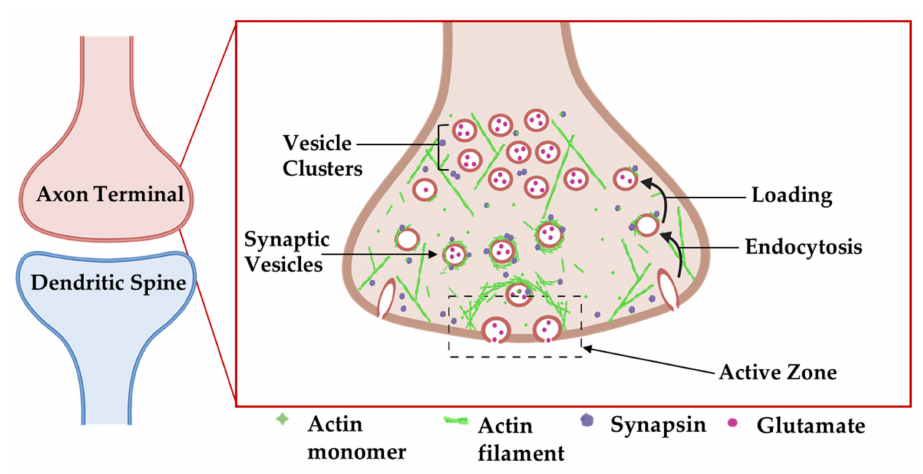
Figure 4. Organization of actin cytoskeleton at the presynaptic axon terminal. Actin filaments form structures presynaptically that affect synapse structure and function. Actin-associated proteins localize to specific areas to carry out their functions. Adapted from “Axonal-dendritic synaptic cleft and Protruding membrane”, by https://BioRender.com (accessed on 26 January 2022) (2020). Created and retrieved from https://app.biorender.com/biorender-templates (accessed on 26 January